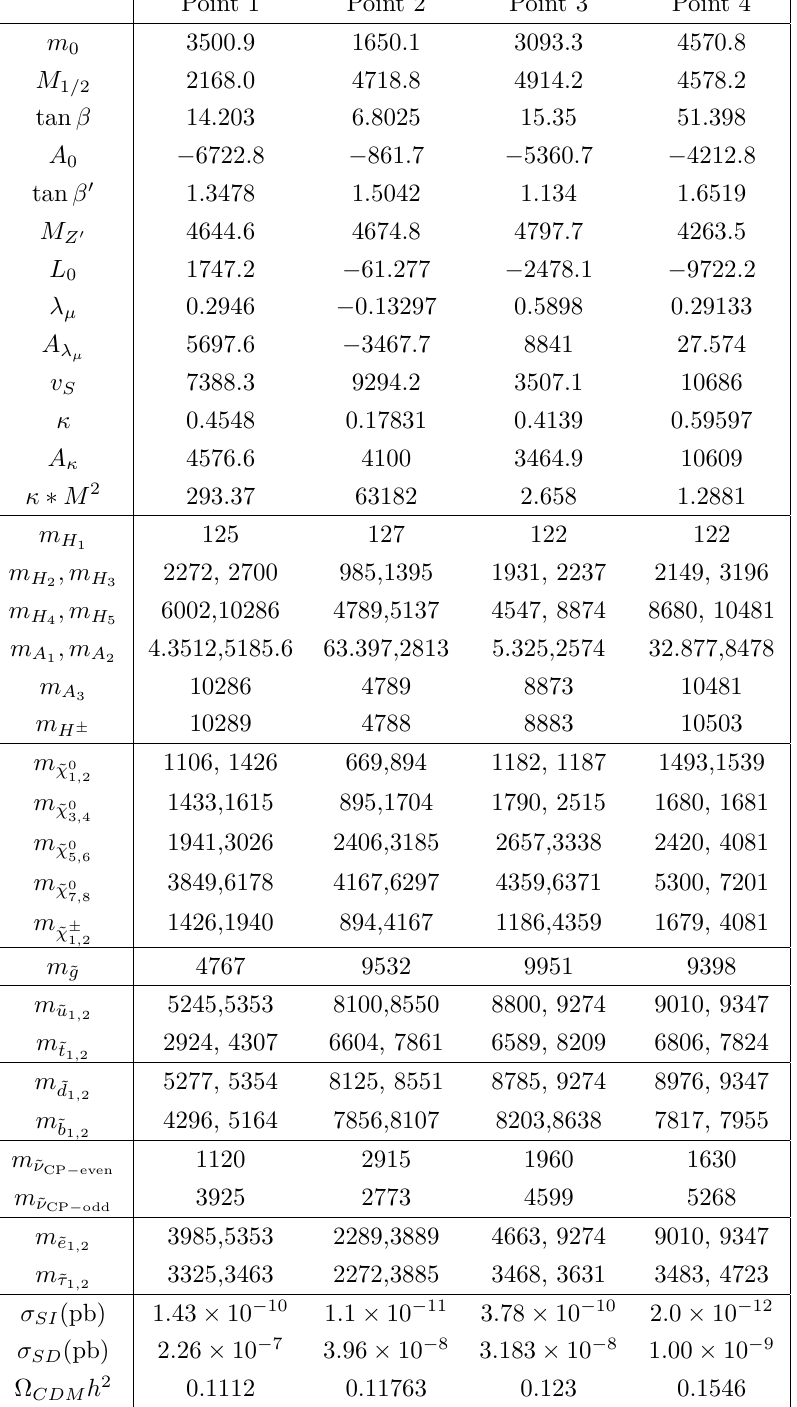
Table 3 . Masses are in units of GeV, µ > 0 and all points satisfy the sparticle mass bounds, and B-physics constraints described in section 3. Points 1 and 2 represent H 2 and H 3 resonance solutions respectively, and point 3 corresponds to selectron A 2 -funnel solution . Point 4 displays an example of blino-type LSP